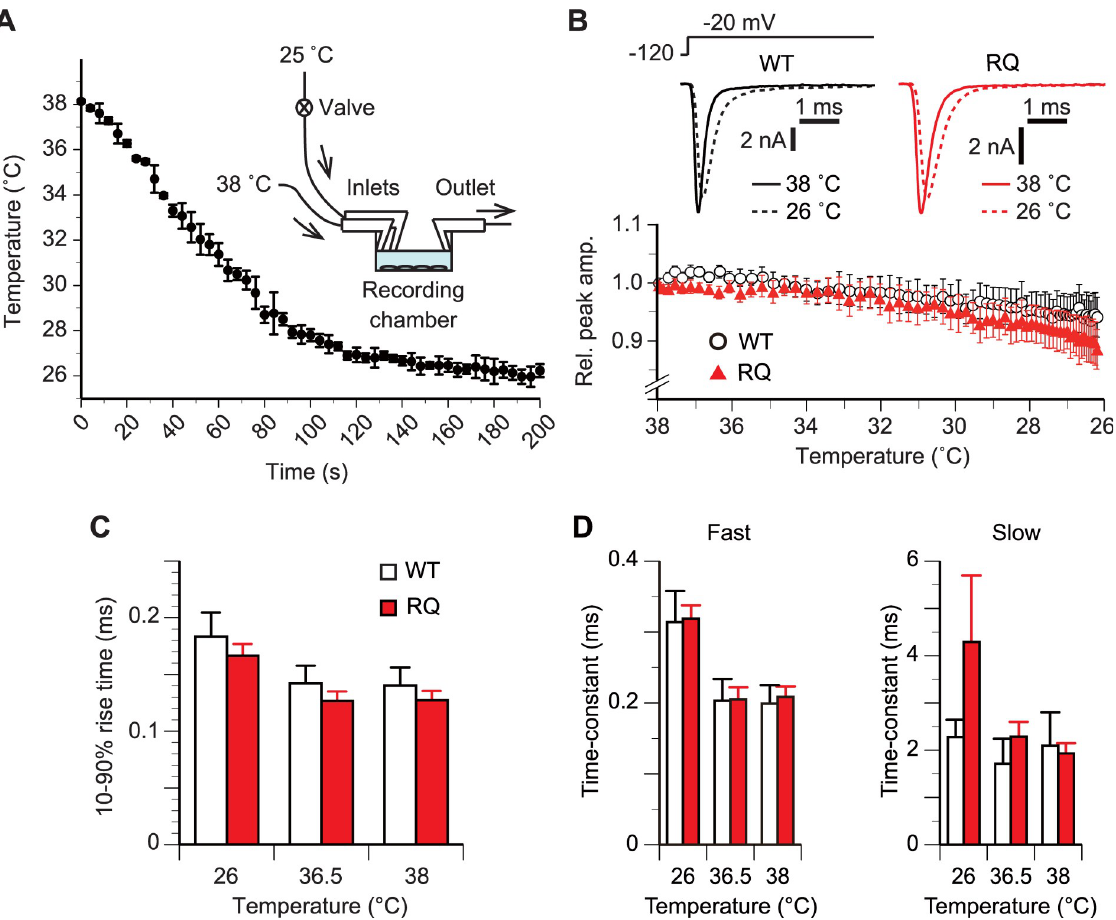
Fig 5. SCN5A(R1193Q) did not alter the amplitude or gating in response to an acute change of temperature. (A) Mean time course of the temperature at the center of the recording chamber after starting the additional influx of room-temperature bath solution. Error bars, ± SD. n, 5 trials. Inset, schematic of the experimental set up. The recording chamber was perfused with pre-heated bath solution (38˚C) throughout the measurement. (B) Time course of the mean relative peak I Na amplitude along with a temperature change from 38˚C to 26˚C. In panels B– D, I Na repeatedly evoked at a test potential of –20 mV in a 2-s interval were analyzed. Holding potential, –120 mV. For each cell, the peak amplitude was normalized to the basal value obtained prior to the lowering of the temperature. p > 0.05 between WT and RQ cells (rmANOVA). n, 8 WT and 8 RQ cells. Inset, representative current responses of single WT and RQ cells at labeled temperatures. (C) Comparison in mean 10%–90% rise time. p > 0.05 between WT and RQ cells for all tested temperatures (rmANOVA, unpaired t -test). n, 8 WT cells and 8 RQ cells. (D) Comparison of mean time constants of fast and slow components of the double-exponential function fitted to the decaying phase of I Na . p > 0.05 between WT and RQ cells for all tested temperatures (rmANOVA, unpaired t -test). n, 7 WT cells and 7 RQ